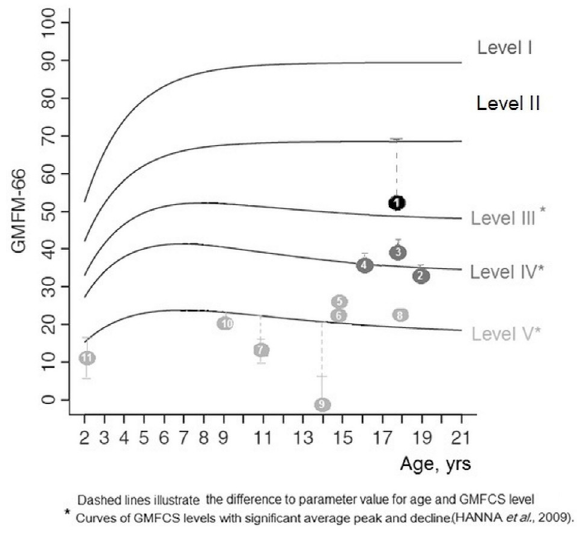
Figure 1. Distribution of the children and adolescents by age, GMFM- 66 means, and GMFCS level